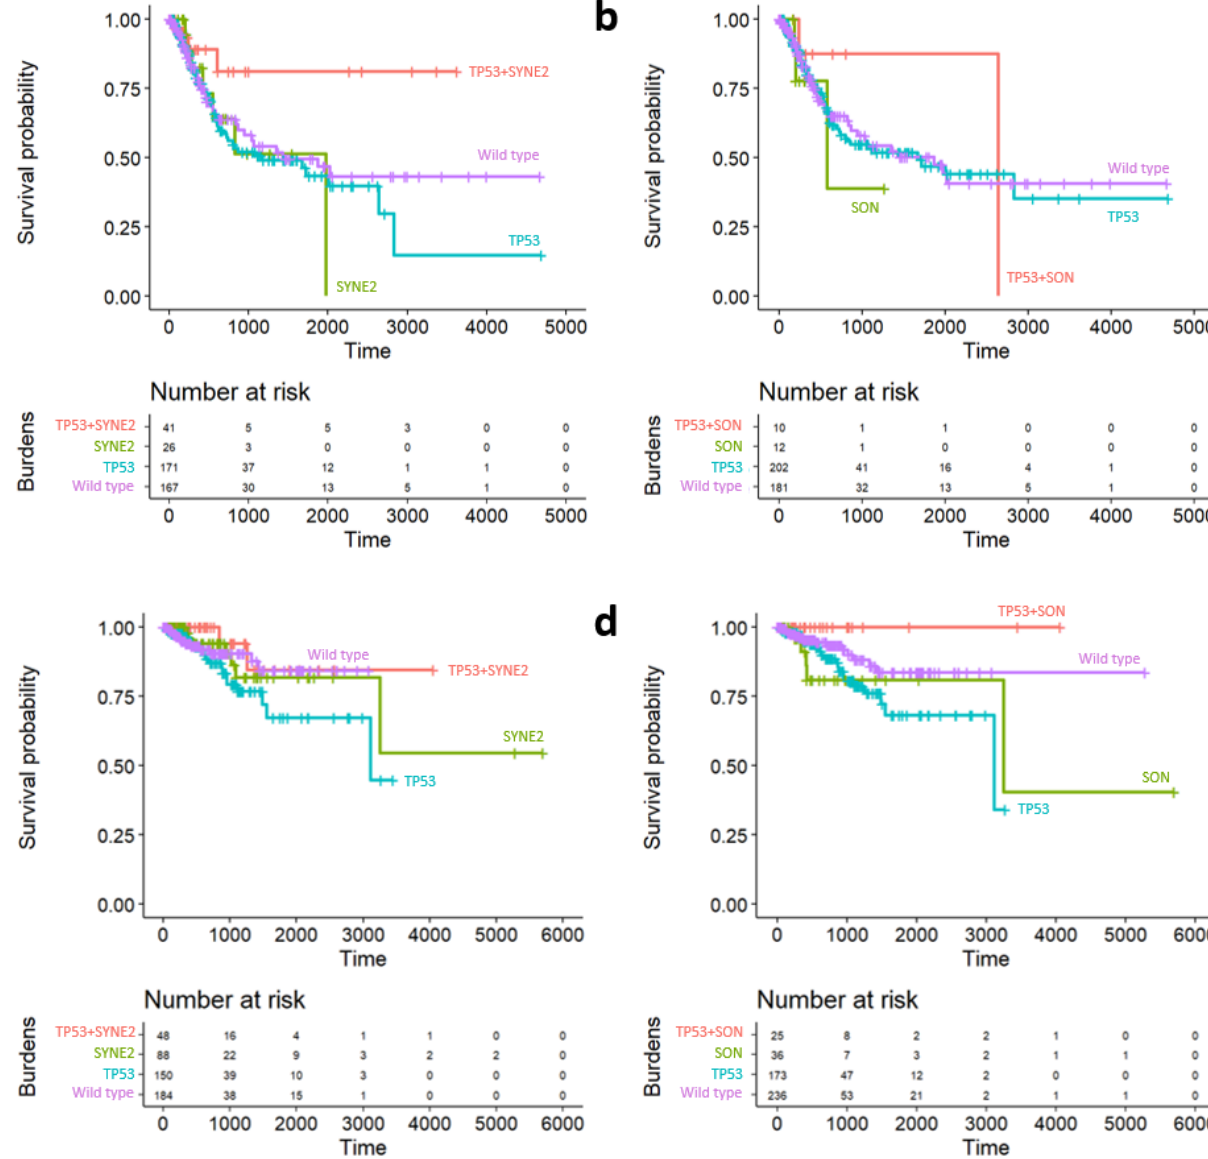
Figure 6. Survival curves according to the events of pair genes constituting synthetic cytotoxicity. ( a ) Patients with disruption in TP53 and SYNE2 mutations in bladder cancer. ( b ) Disruption in TP53 and SON mutations in bladder cancer. ( c ) Patients with disruption in TP53 and SYNE2 mutations in uterine cancer. ( d ) Disruption in TP53 and SON mutations in uterine cancer.